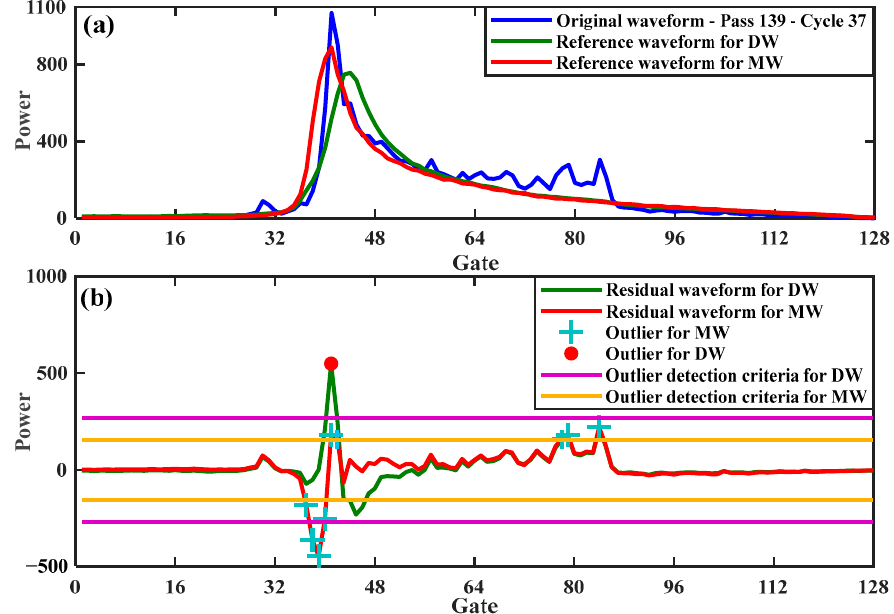
Figure 9. Fitting the reference waveforms ( a ) and detection of outliers ( b ) in a particular waveform of pass 139 and cycle 37 over the Persian Gulf using the modification and decontamination strategies. The decontaminated waveforms were then retracked using the threshold retracker to evaluate the performance of this